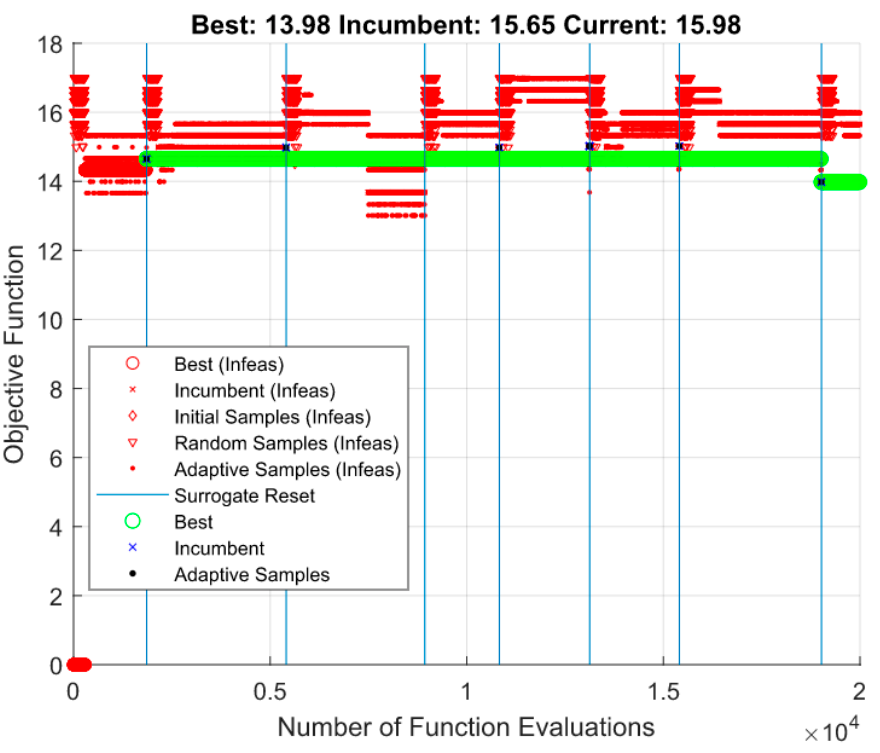
Figure 6. Solution of the task (Variant #3). Table 9. Comparison of the results of the delivery time for the three